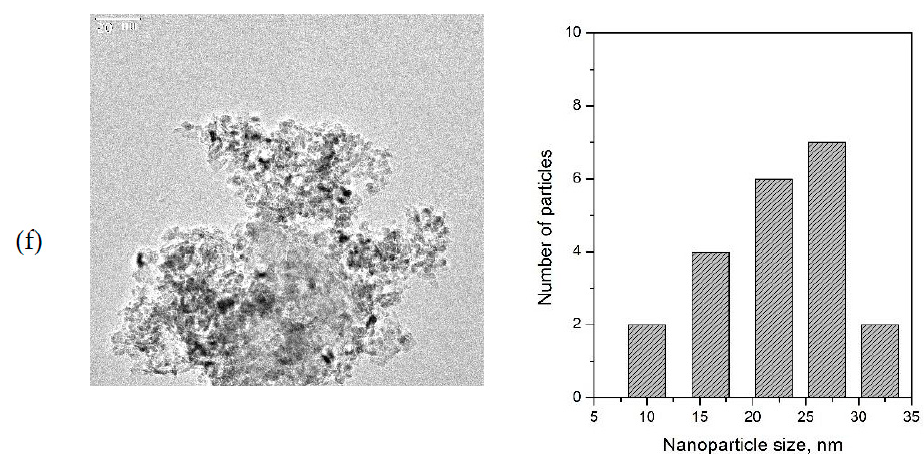
Figure 14. TEM images of reduced Ni-Mg-Al catalysts ( a ) 20 wt%, ( b ) 40 wt%, ( c ) 60 wt% Ni and spent Ni-Mg-Al catalyst ( d ) 20 wt%, ( e ) 40 wt%, ( f ) 60 wt%.